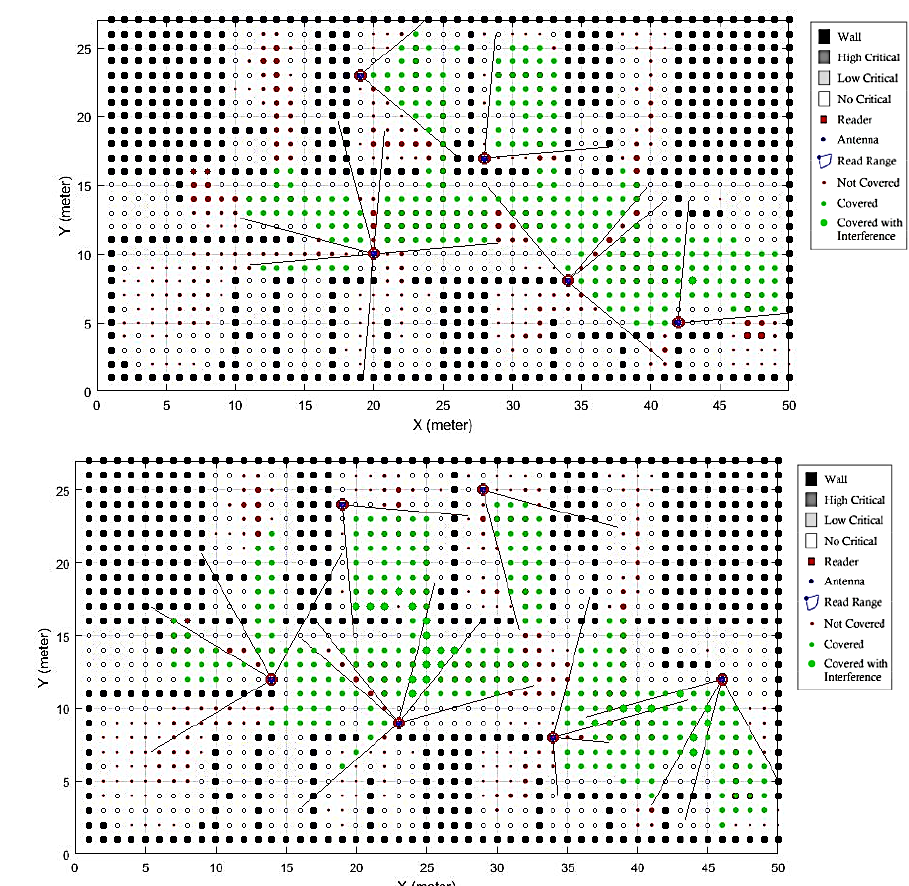
Fig. 15. Results of the GA-SA algorithm for scenario 2: coverage=70%, cost=20 ×1000$.